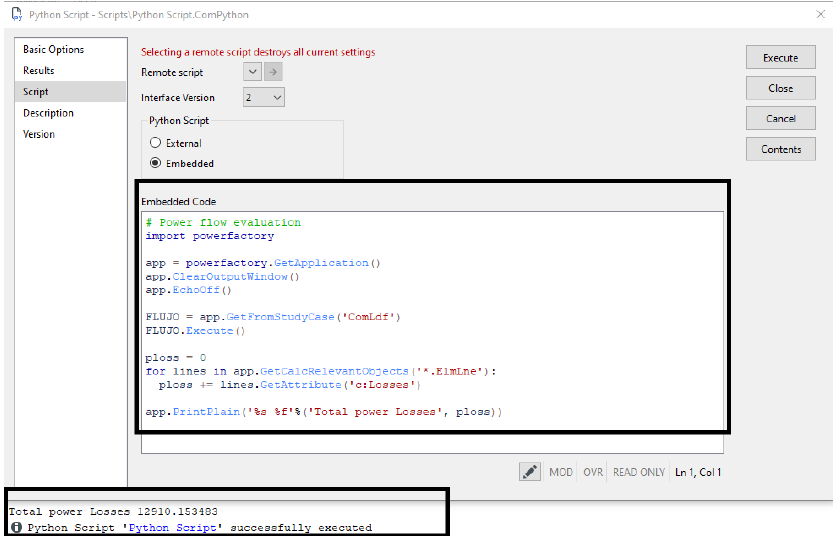
Figure 1. Example of an AC load flow loss calculation (evaluated using Newton–Raphson) in Python-DIgSILENT script software.